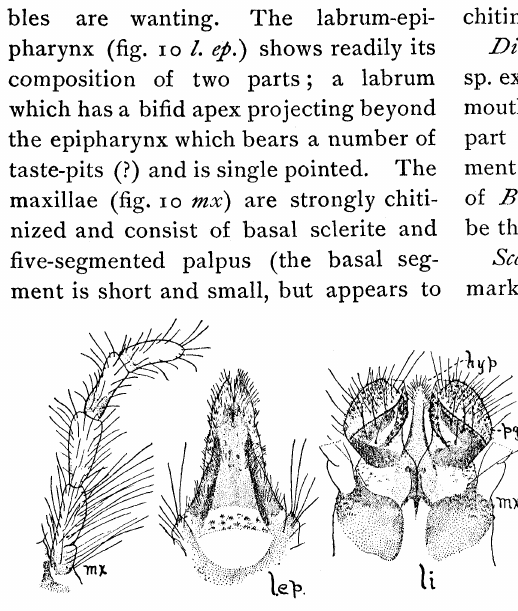
Fig. io, Mouthparts of Bibio sp; 1.